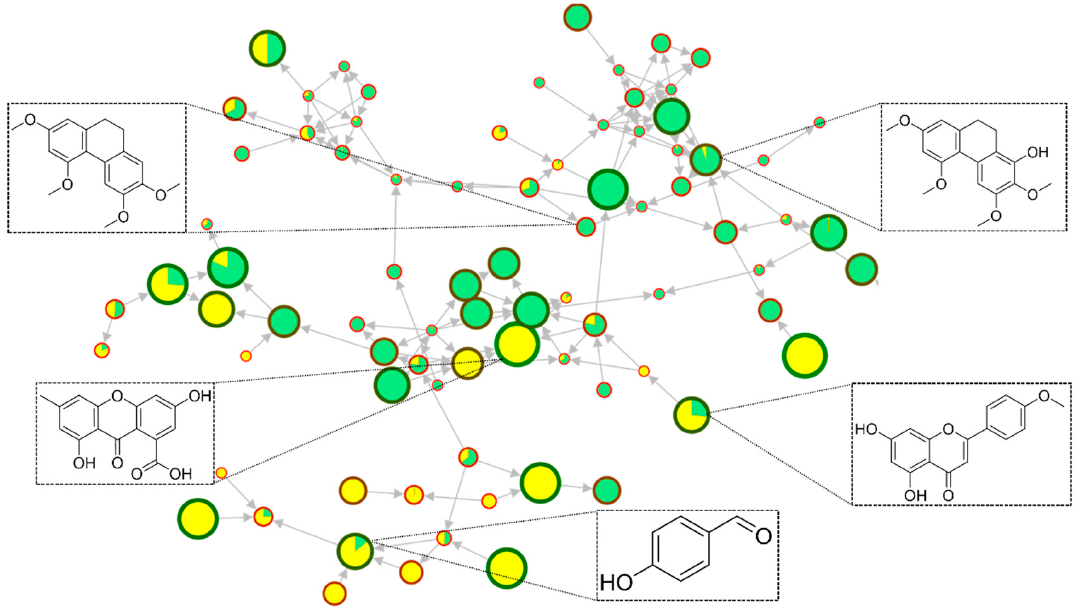
Figure 3. Molecular families annotated by classical molecular networking (MN) of the samples from fungal-infected plants (green) and healthy plants (yellow) and the metabolites found through GNPS library hits.